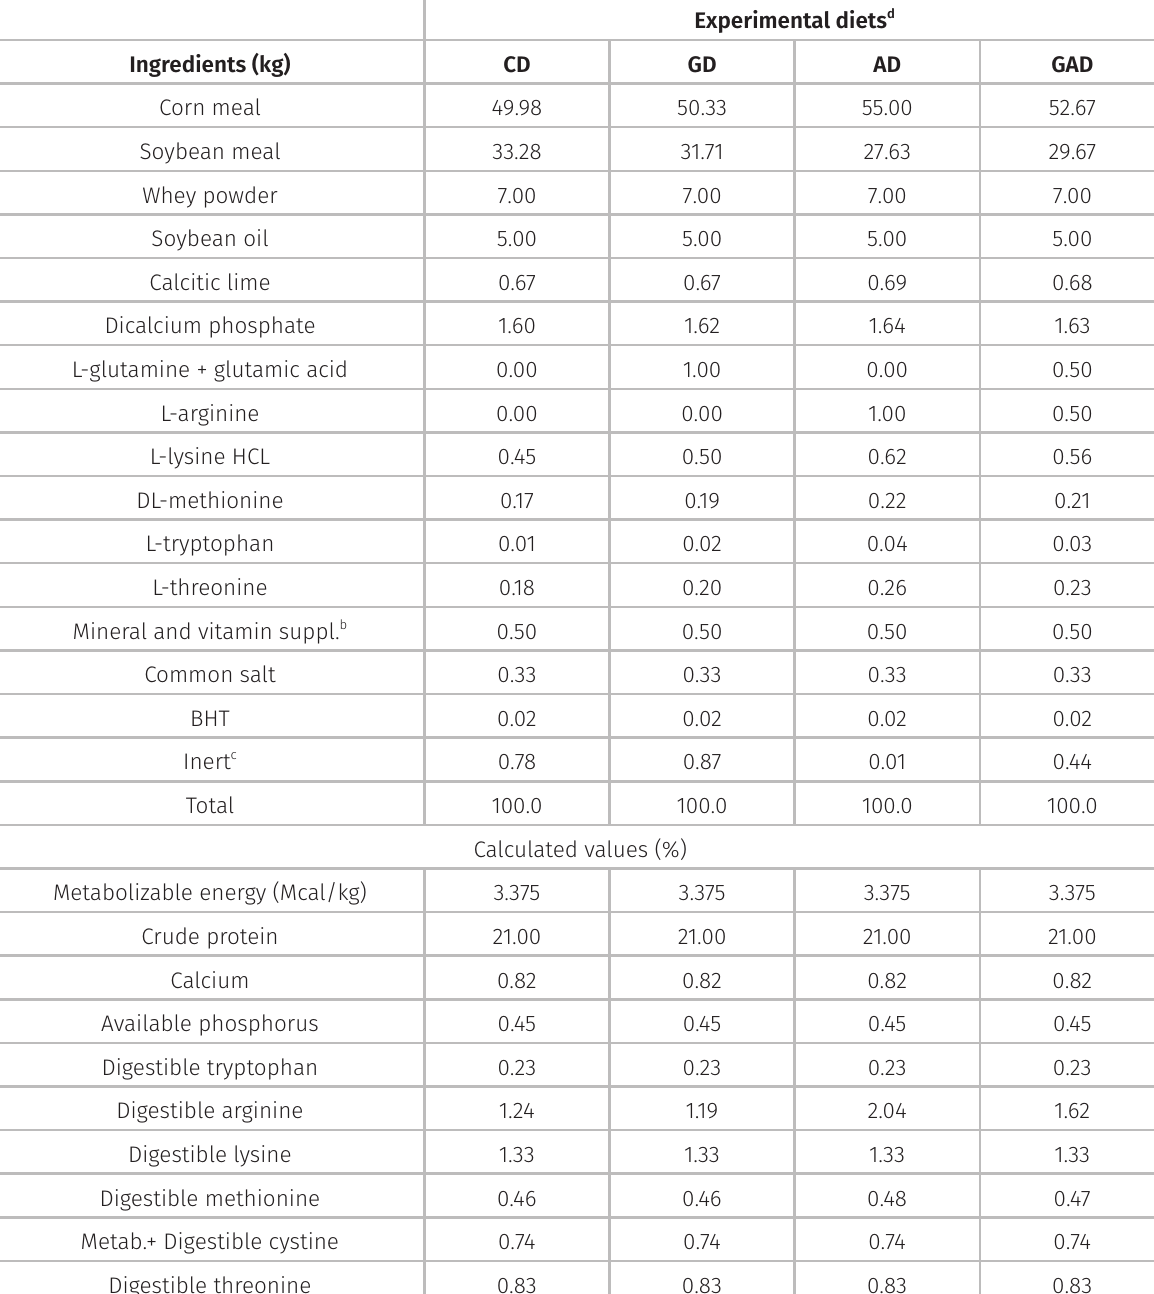
Experimental diets d